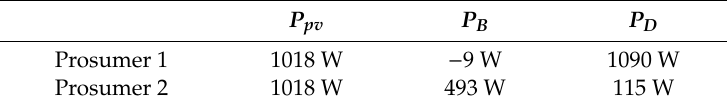
Table 2. Power values for each prosumer for the simulation test.